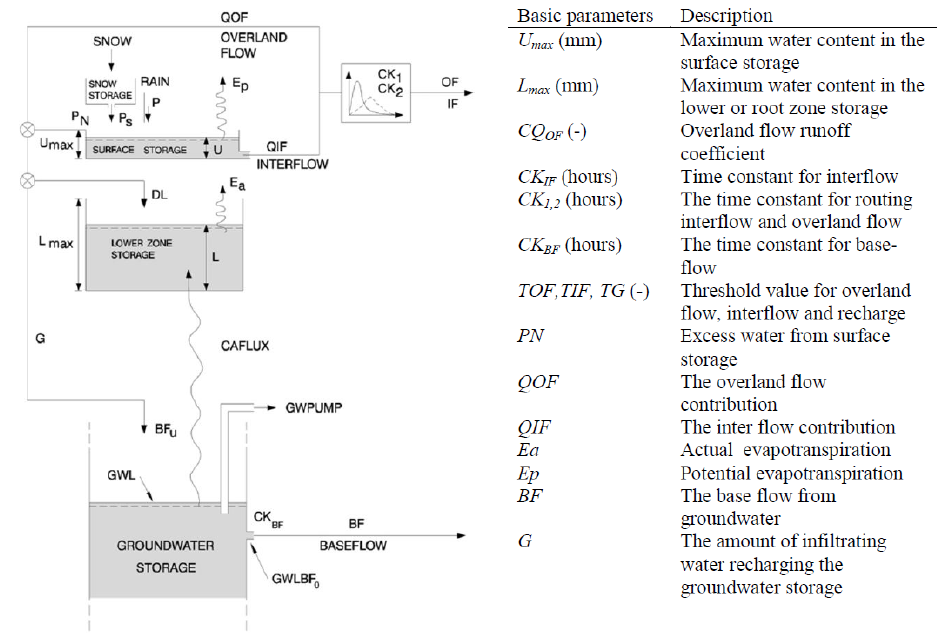
Figure 3: Model structure of NAM and description of the basic parameters (DHI, 2008)